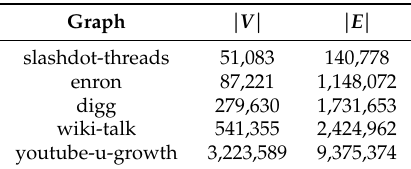
Table 4. Real graphs used in experiments. Columns are graph name, number of vertices, and number of